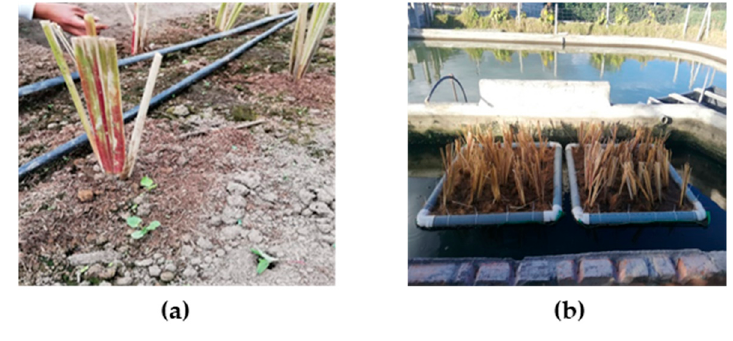
Figure 3. Vetiver plant adaptation: ( a ) soil and ( b ) water.